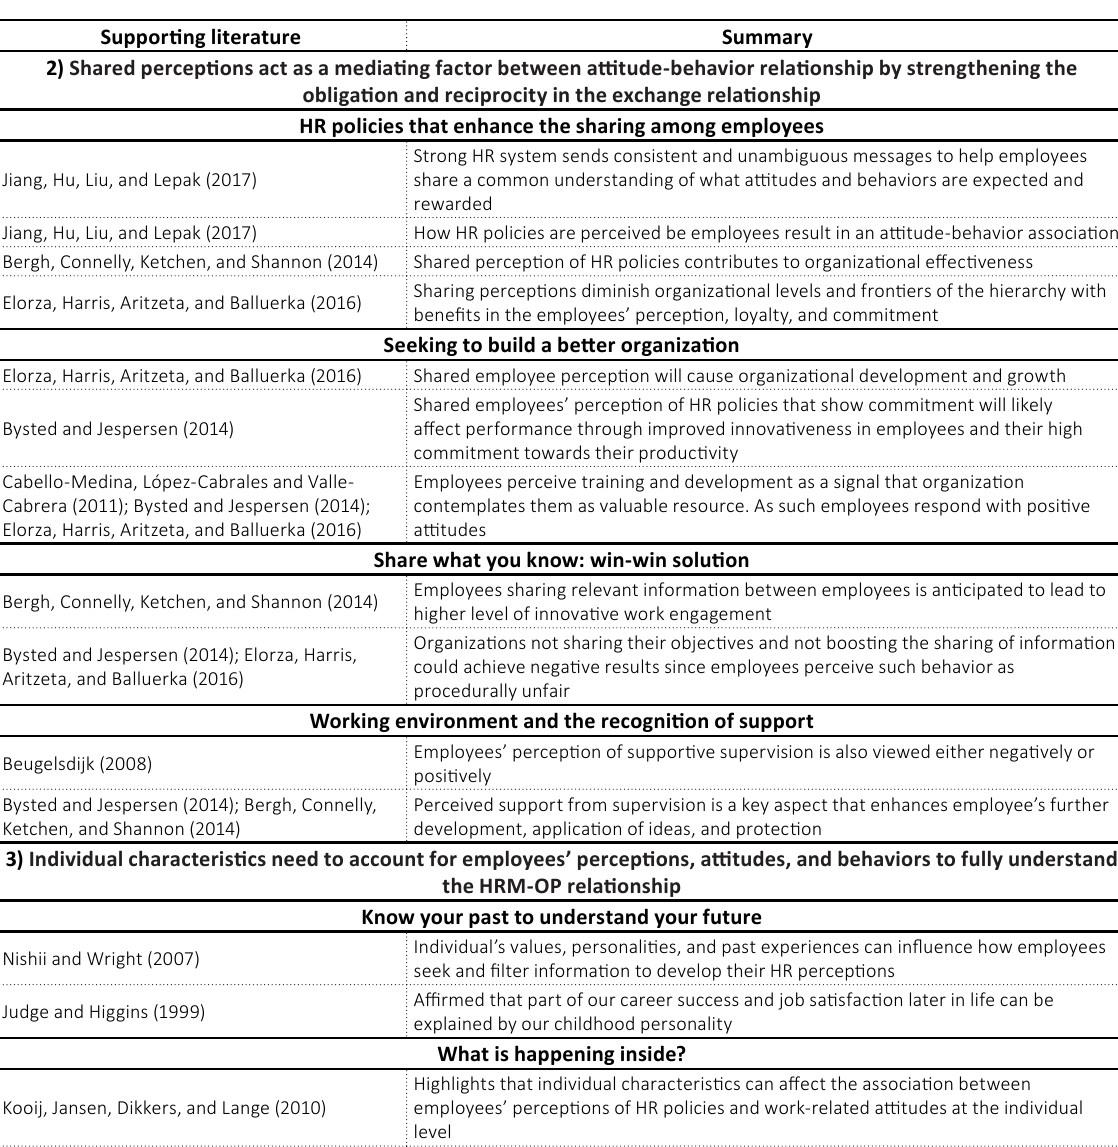
Table 2 (cont.). Workers’ behavior and individual